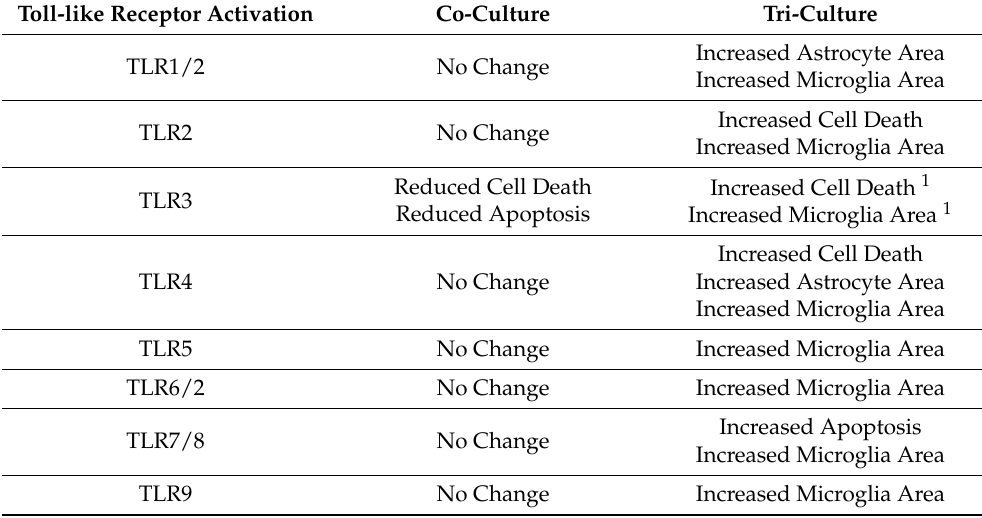
Table 1. Summary of co- and tri-culture response to TLR activation as compared to their respective vehicle